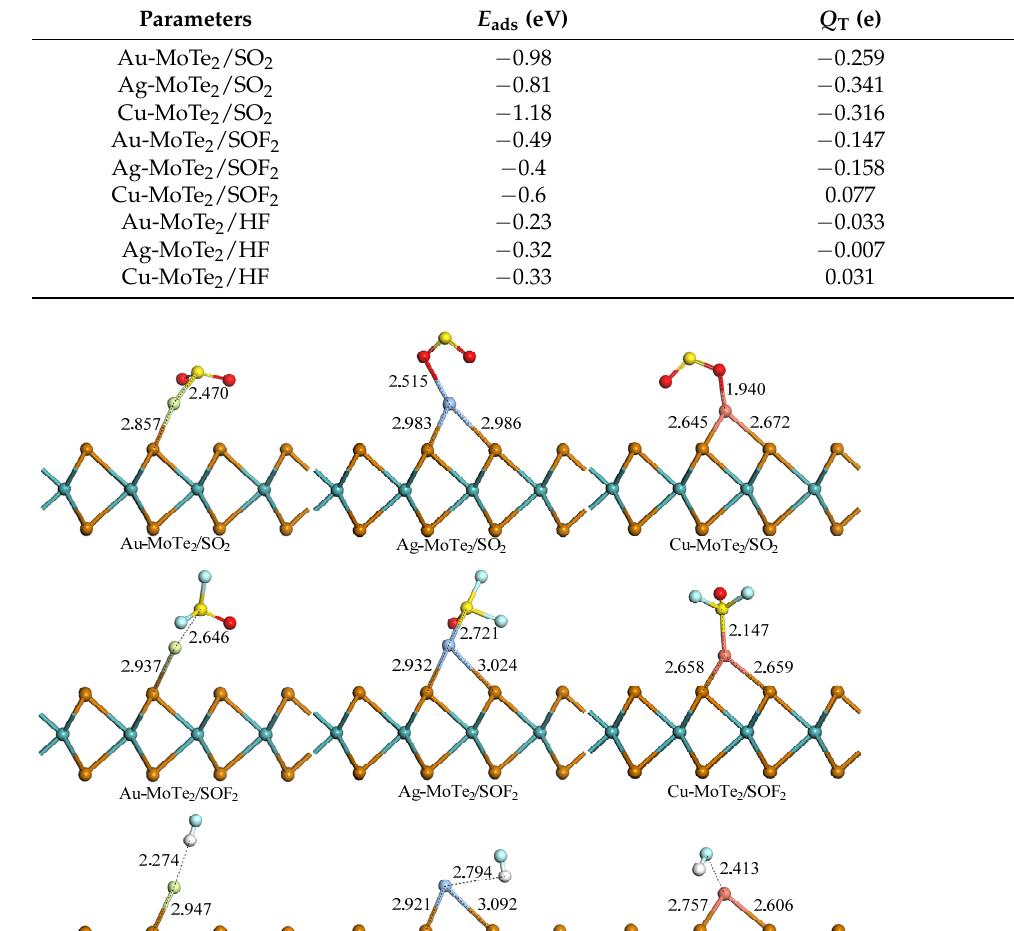
Table 2. Adsorption energy and electron transfer of gas molecules on TM-MoTe 2 monolayer.